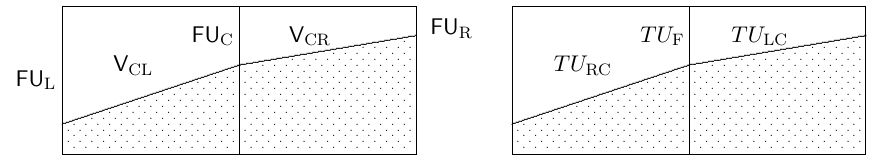
Figure 4. Two neighbored cut cells with face and volume area information (left) and arrangement of face- and cell-centered tendency of momentum (right).